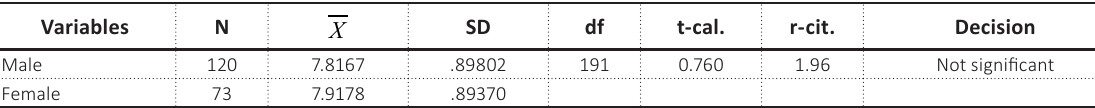
Table 14. Gender of a forensic